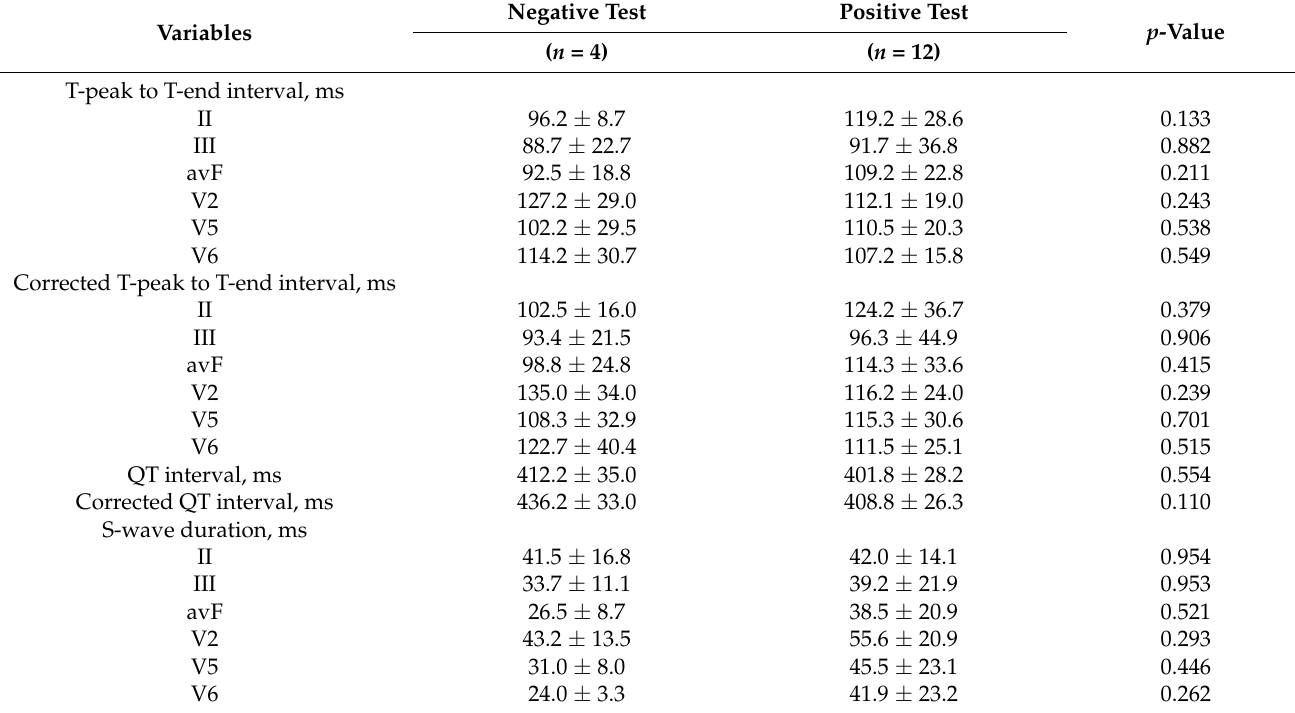
Table 2. Electrocardiographic parameters according to ajmaline challenge test